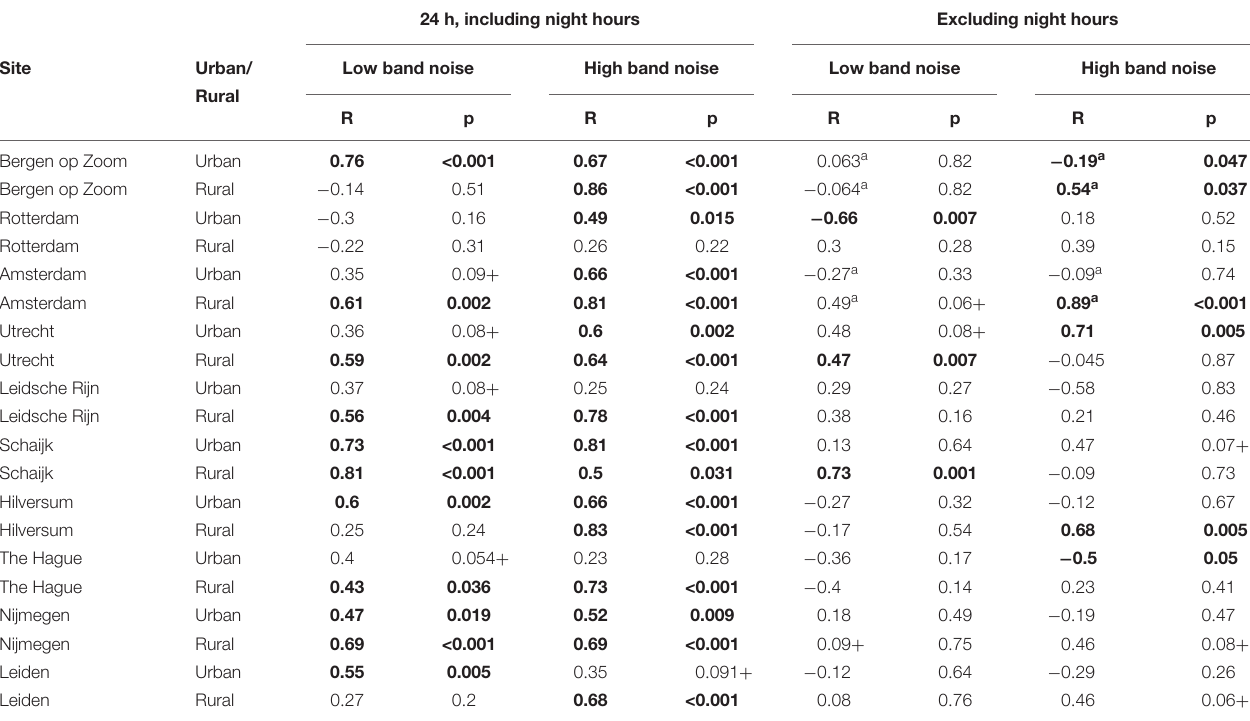
TABLE 3 | Correlations between number of songs and noise amplitude levels relative to the noise average of the day, for each site (urban and rural) and for each frequency band (low band noise: 200–400 Hz; high band noise: 2000–4000 Hz). 24 h, including night hours Excluding night